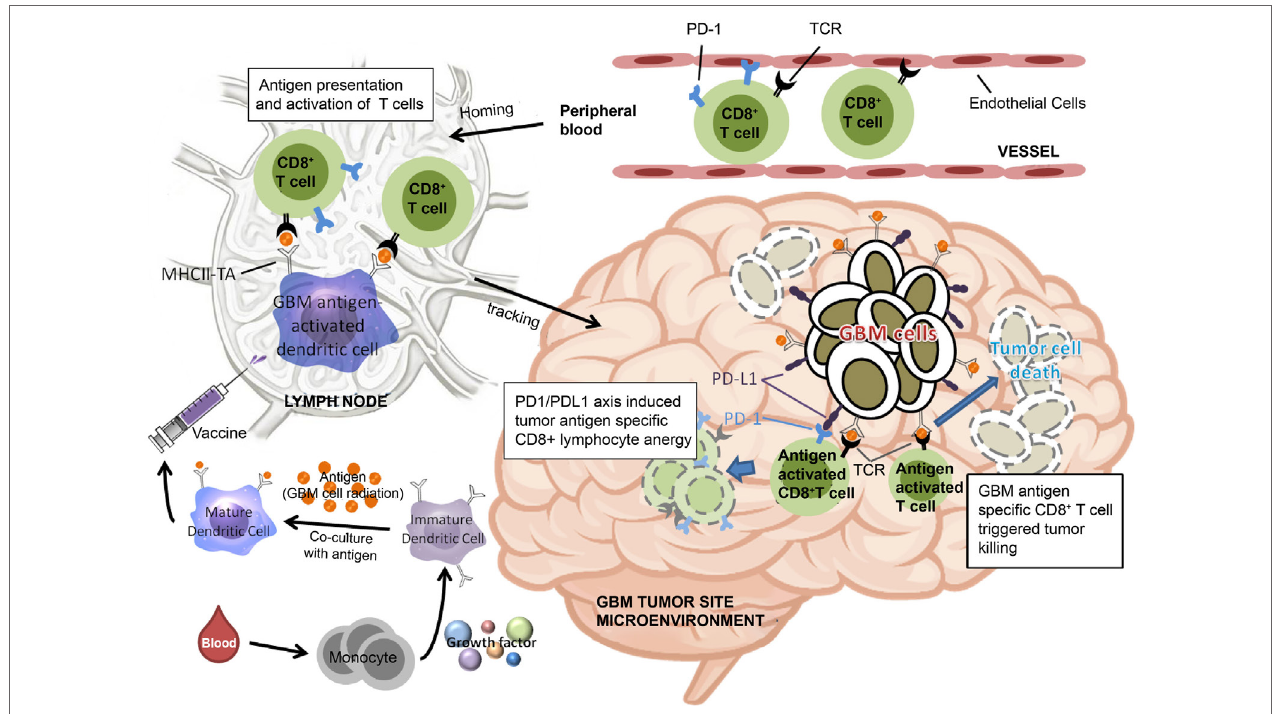
FigUre 11 | Schematic representation of dendritic cell vaccine treatment PD-1 + or PD-1 − cytotoxic T cells in the peripheral blood arrive at lymph nodes for antigen activation after vaccination. After reaching the tumor microenvironment, the efficiency of tumor cell killing by cytotoxic T cells is determined by the proportion of PD-1 + cytotoxic T